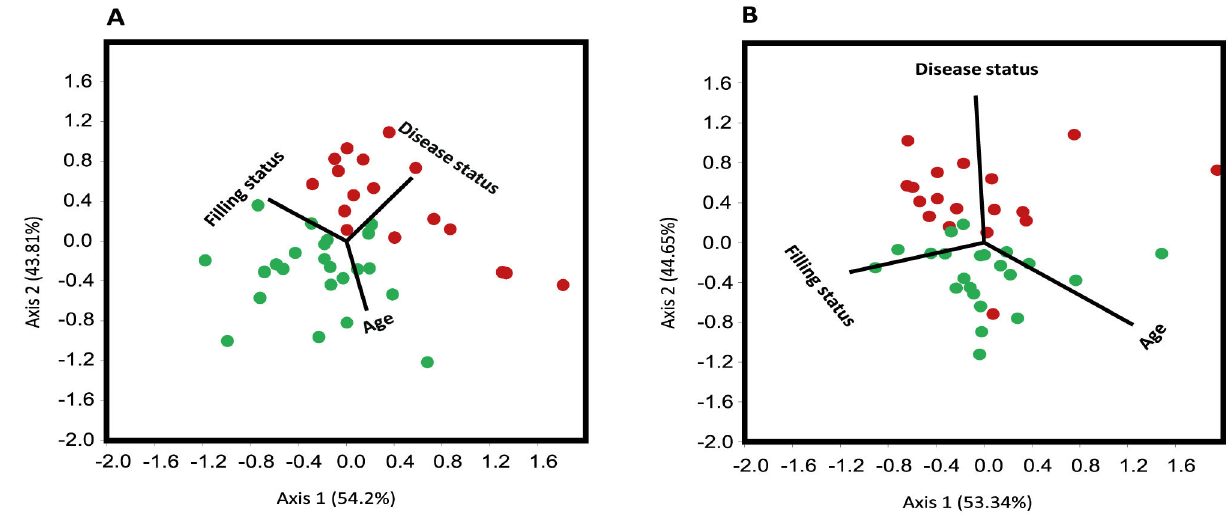
Figure 5. Canonical Correspondence Analysis of symptomatic and asymptomatic secondary root canal infections on species-level (A; 3% dissimilarity) and genus-level (B; 5% dissimilarity). The samples group together according to the disease status (symptomatic – asymptomatic) with the factors ‘age’ and ‘filling status’ taken into account (red = symptomatic, green = asymptomatic).